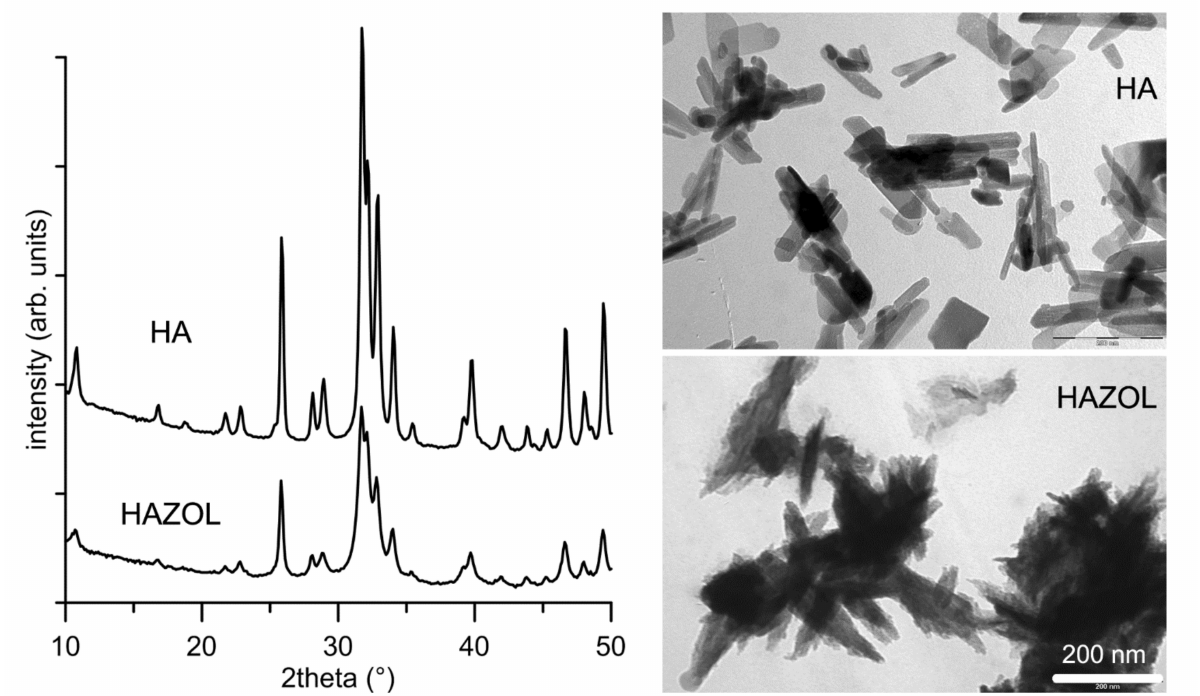
Figure 2. Powder X-ray diffraction patterns and TEM images of HA and HAZOL nanocrystals. Scale bar (200 nm) is common for the two images, for direct comparison. arb. = arbitrary.